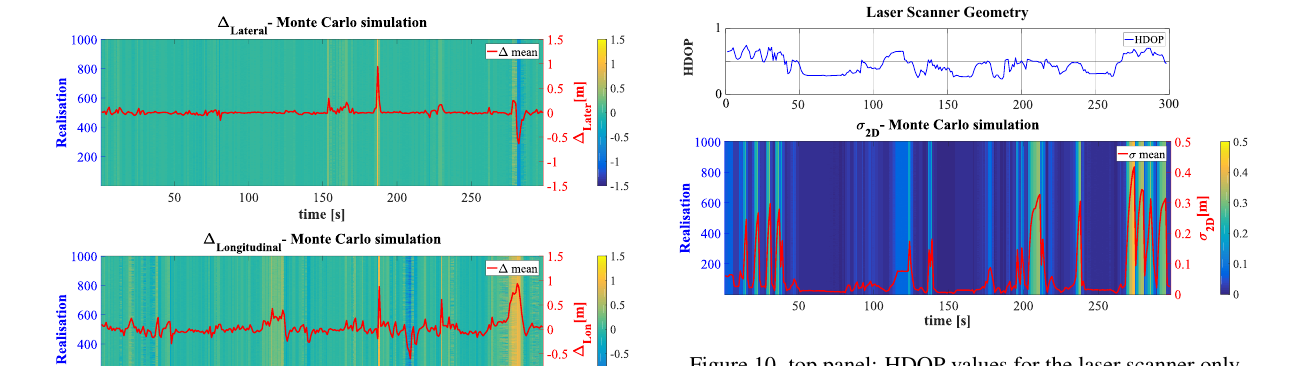
Figure 10. top panel: HDOP values for the laser scanner only. Vehicle 1 - Sensor setup 1. Bottom panel: 3D standard deviation obtained from P +